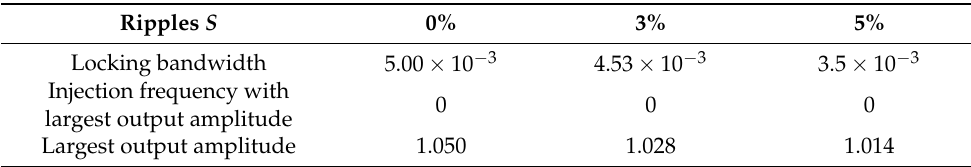
Table 1. Comparison of injection locking in different ripples.